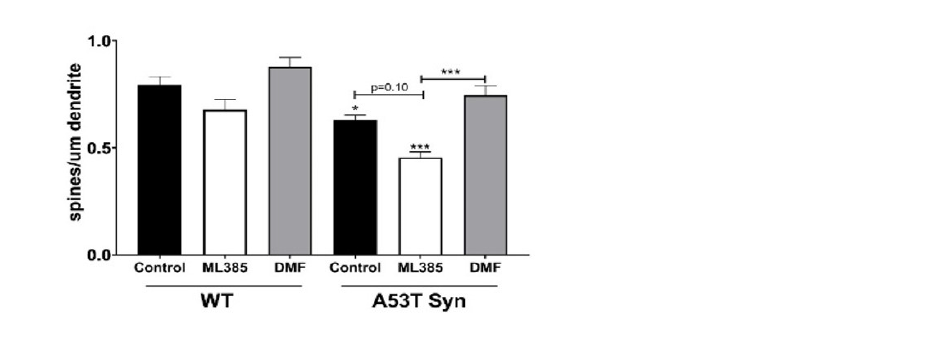
Figure 7. DMF increases spine density in A53TSyn neurons while ML385 treatment reduces it. Significance is relative to control unless otherwise indicated ( * p < 0.05, ** p < 0.01, *** p < 0.001).